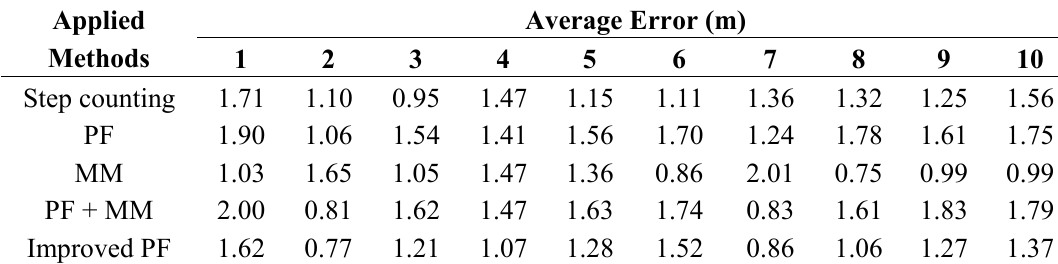
Table 4. Average error for each trial (map 1, route 2).